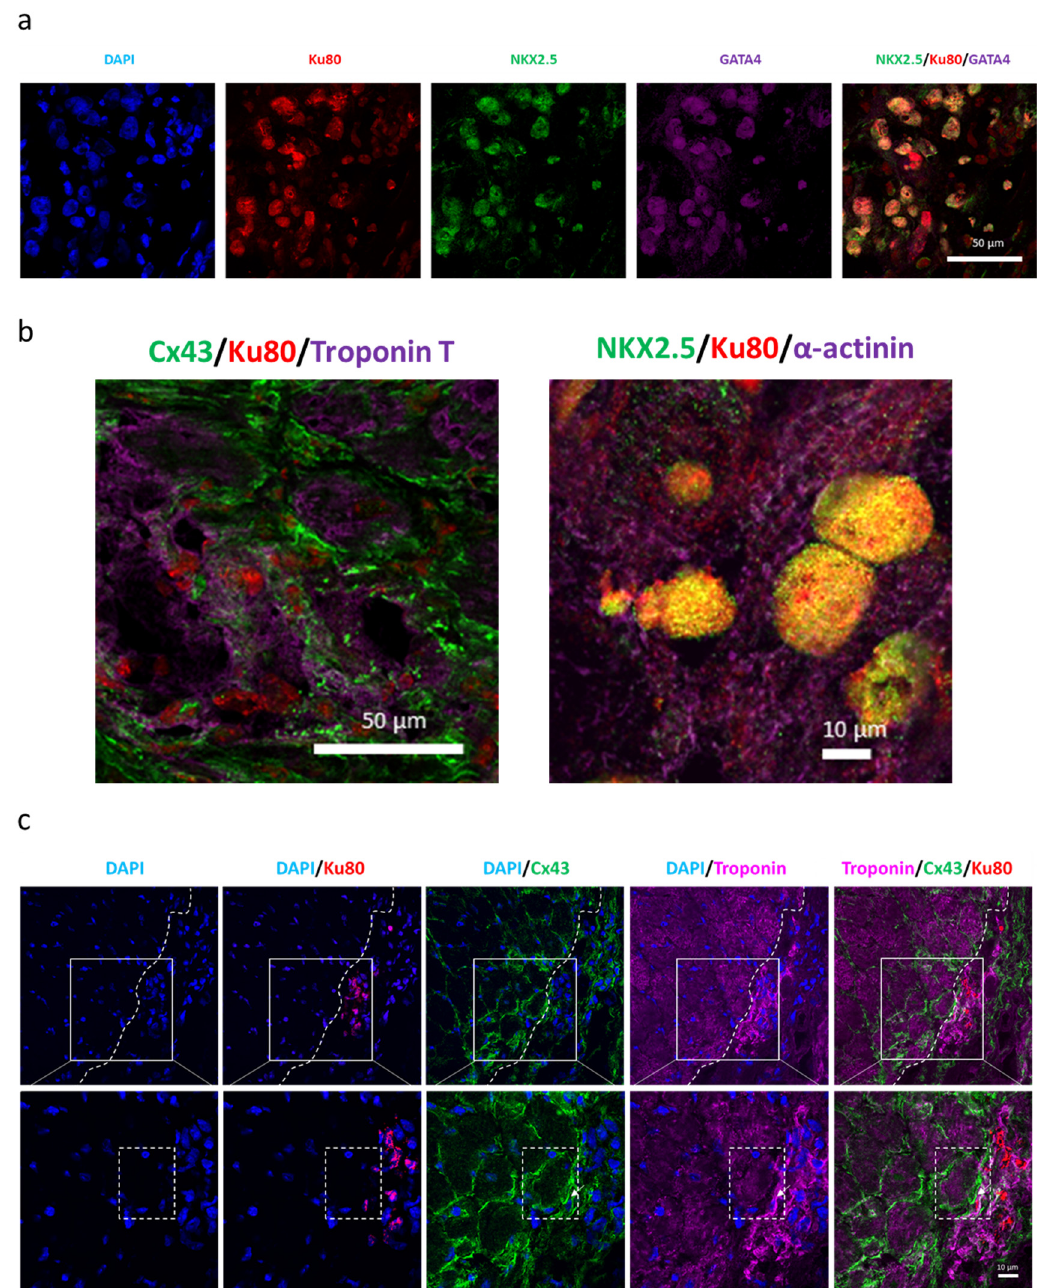
Figure 8. Expression of cardiac markers in human cells detected in murine myocardium. ( a ) Representative pictures for immunofluorescent analysis of human Ku80 (red), NKX2.5 (green) and GATA4 (purple) in murine heart subjected to MI and hiPSC-CM-SDF-1-Luc-GFP administration. Nuclei stained with DAPI (blue). ( b ) Representative pictures for immunofluorescent analysis of human Ku80 (red), connexin 43 (Cx43, green) and troponin T (purple) in the left panel and NKX2.5 (green) and α -actinin (purple) in the right panel in murine heart subjected to MI and hiPSC-CM-SDF-1-Luc-GFP administration. Nuclei stained with DAPI (blue). ( c ) Representative pictures for immunofluorescent analysis of human Ku80 (red), connexin 43 (Cx43, green) and troponin T (purple) in murine heart subjected to MI and hiPSC-CM-SDF-1-Luc-GFP administration. Nuclei stained with DAPI (blue). Similar results were obtained for hiPSC-CMs-Luc-GFP and hiPSC-CMs-HO-1-Luc-GFP (Supplementary Figure S9).